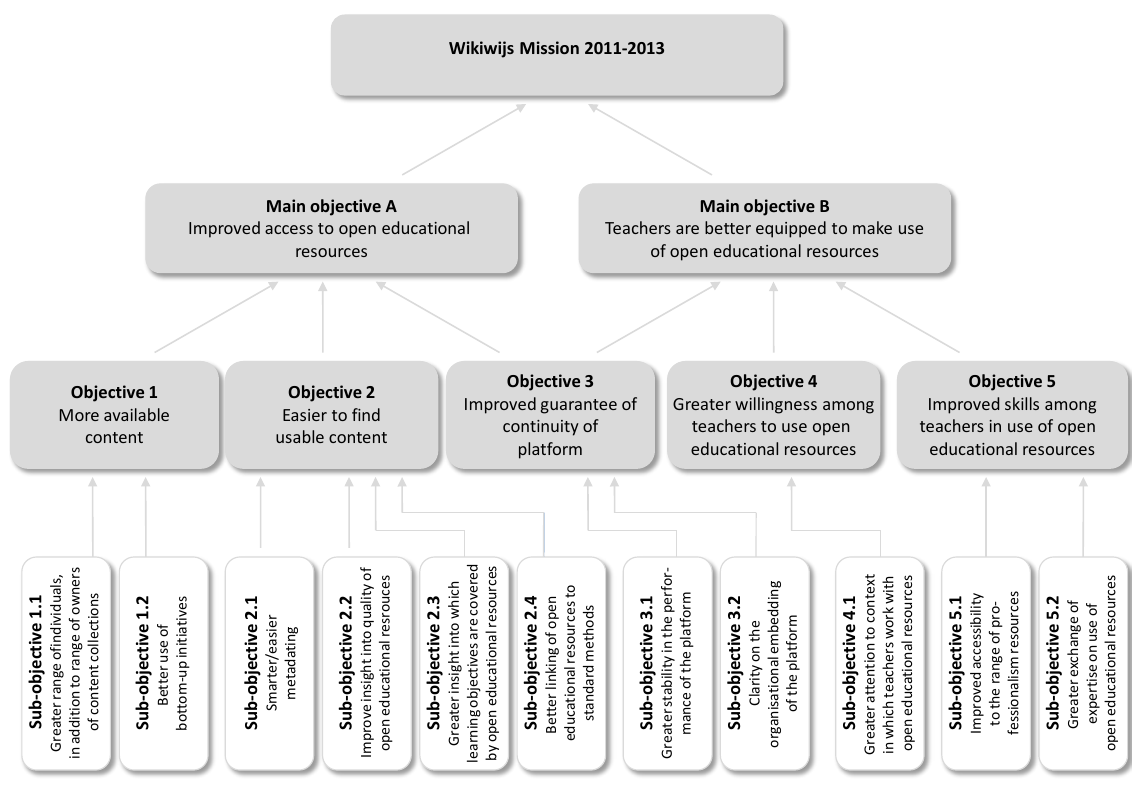
Figure 1 . An objectives tree for Wikiwijs